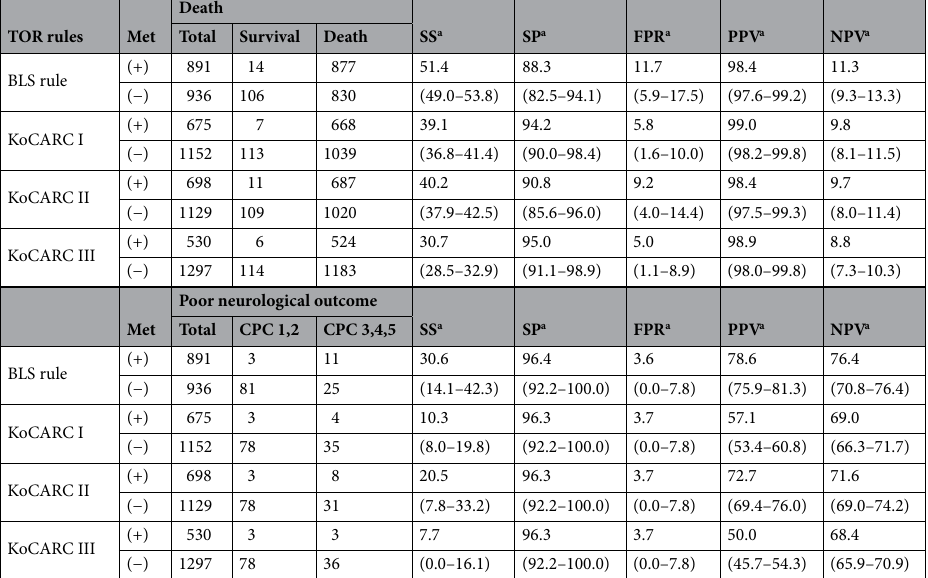
Table 2. Predictive performance of TOR rules for death and poor neurological outcomes at hospital discharge. TOR, termination of resuscitation; SS, sensitivity; SP, specificity; FPR, false-positive rate; PPV, positive predictive value; NPV, negative predictive value; BLS, basic life support; KoCARC, Korean Cardiac Arrest Research Consortium; CPC, cerebral performance category. CPC 1 and 2 were defined as favorable neurological outcomes, and CPC 3, 4, and 5 as poor neurological outcomes. a Variables are presented as the number and 95% confidence interval.